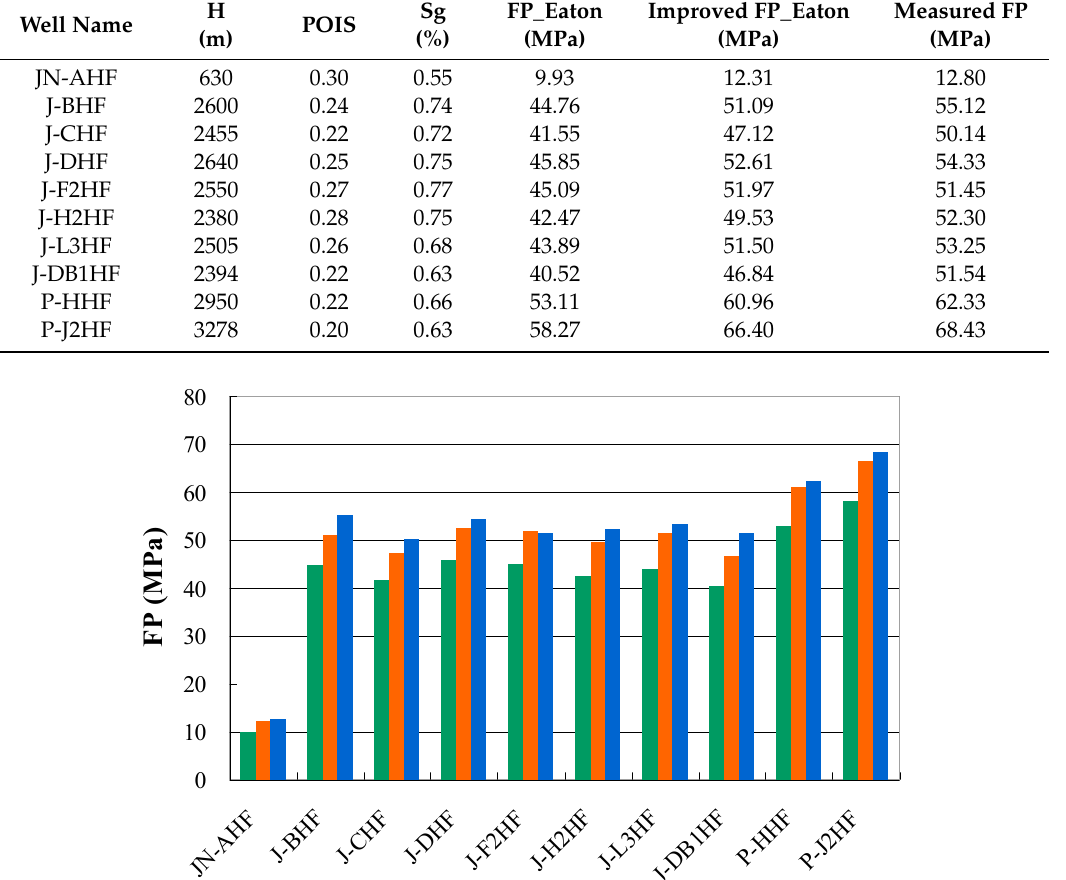
Table 2. Analysis data of fracture pressure of shale gas wells in the Sichuan Basin.